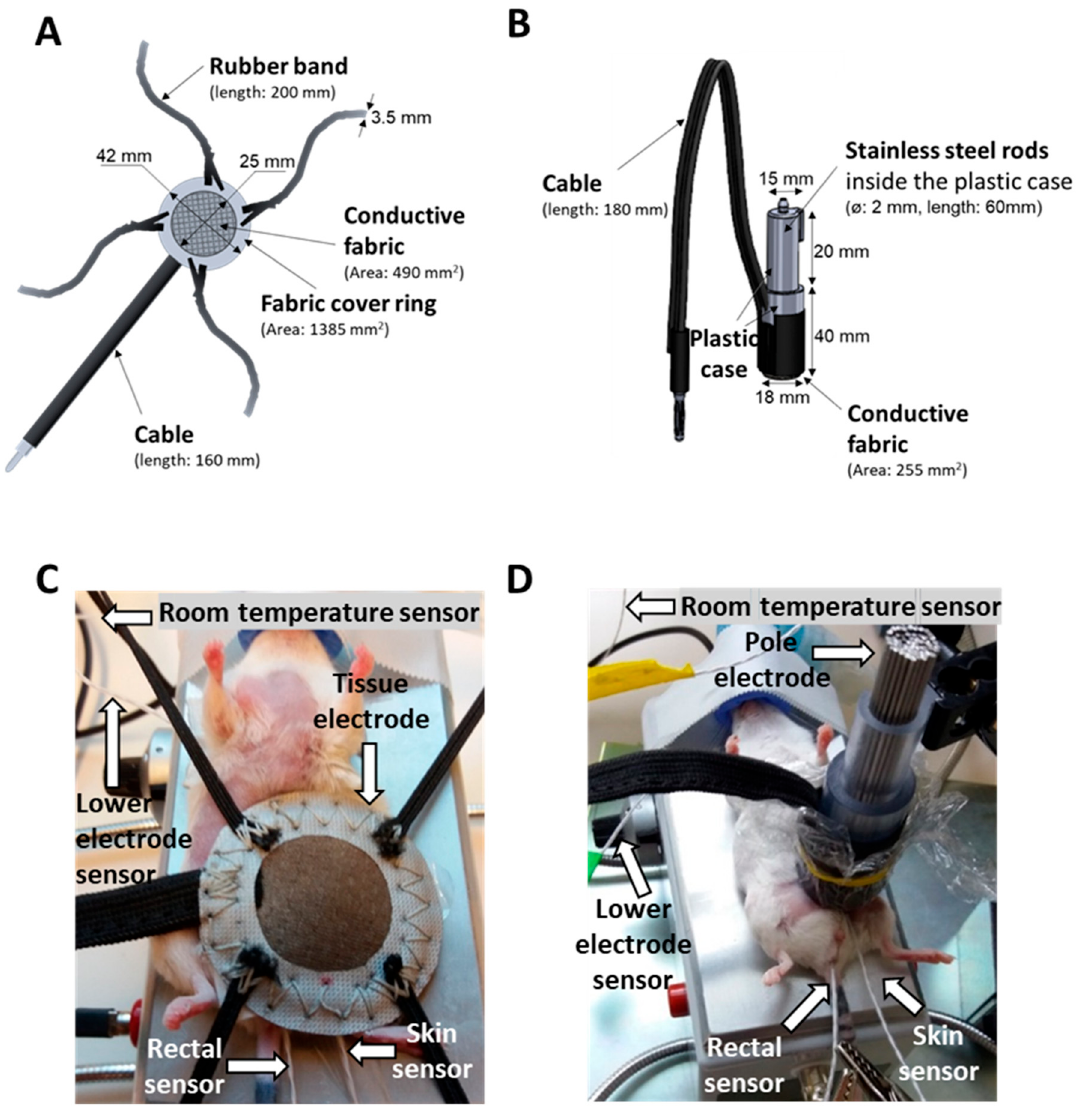
Figure 12. Comparison of the mEHT treatment setups. Schematic diagram and dimensions of the ( A , C ) previously used tissue electrode and ( B , D ) improved pole electrode. Animal on the lower electrode with ( A , C ) the tissue electrode and ( B , D ) the pole electrode. The electromagnetic field was established between the lower electrode and the upper electrode positioned on the tumor. The temperature at the four locations is monitored by temperature sensors (rectal, skin, lower electrode, and background).